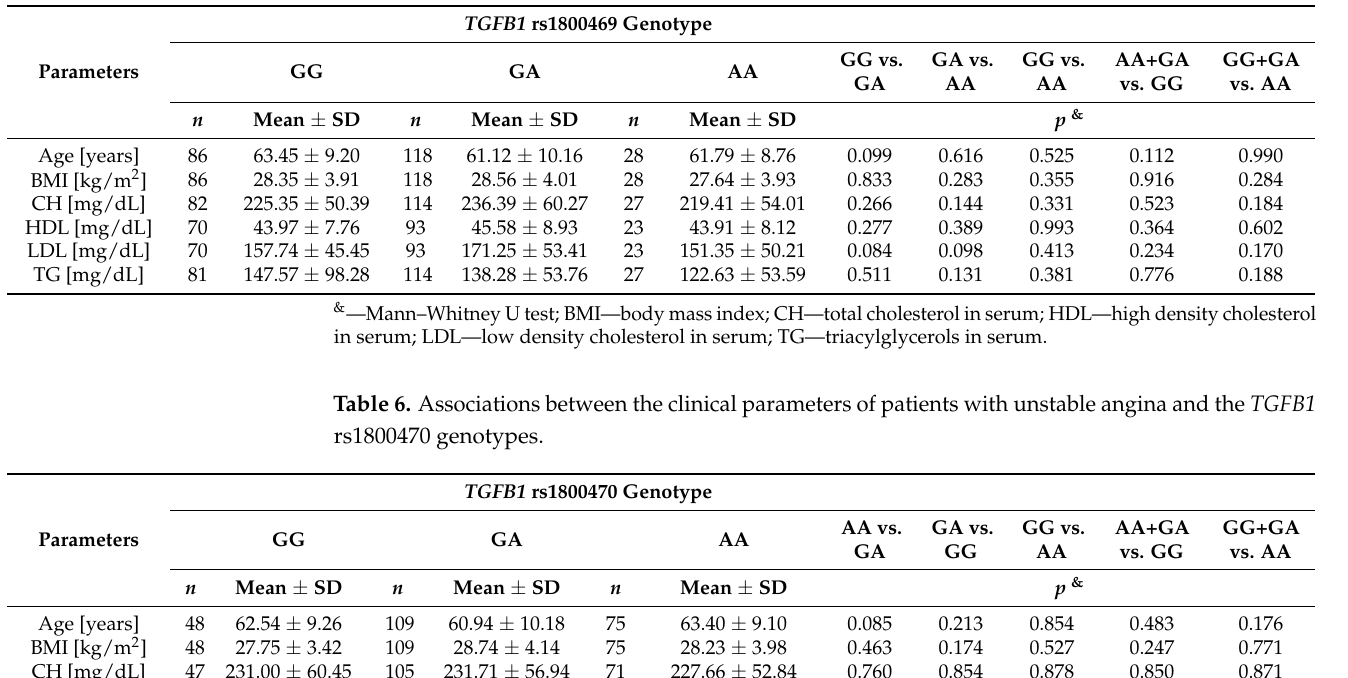
Table 5. Associations between the clinical parameters of patients with unstable angina and the TGFB1 rs1800469 genotypes.